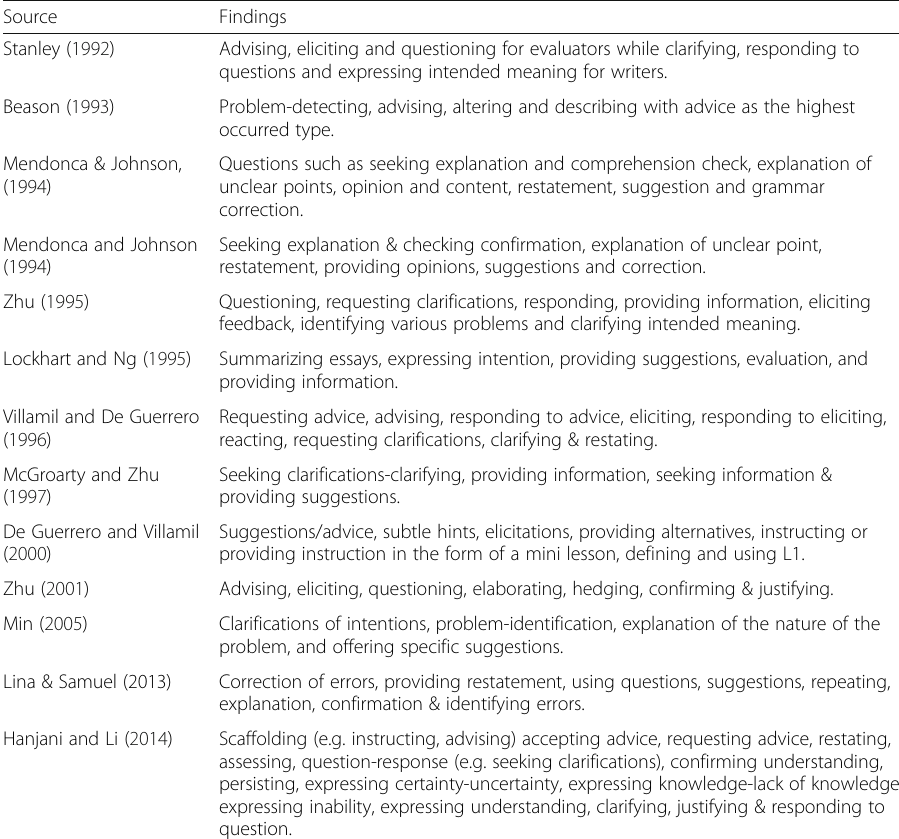
Table 1 were conducted on FFPR. Patterns of feedback that are exploratory func- tioned as advising, eliciting and questioning as well as responses to questions and clarifications of information and intended meaning (Stanley, 1992). Other functions